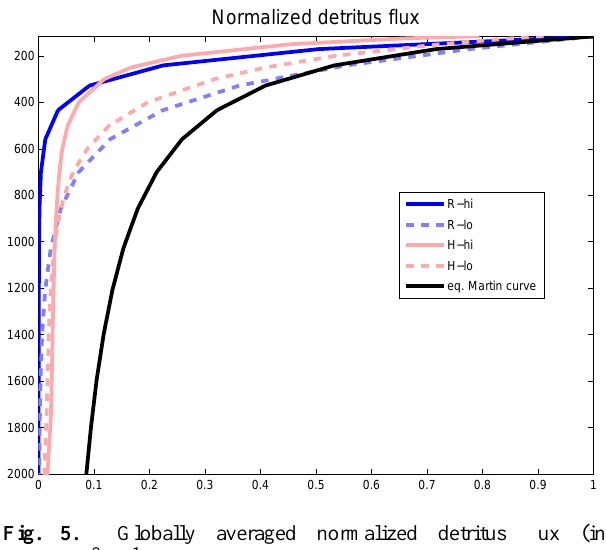
Fig. 5. Globally averaged normalized detritus flux (in mmol/m 2 /day) and comparison to the theoretical Martin curve. In blue: GISSER, in red: GISSEH.